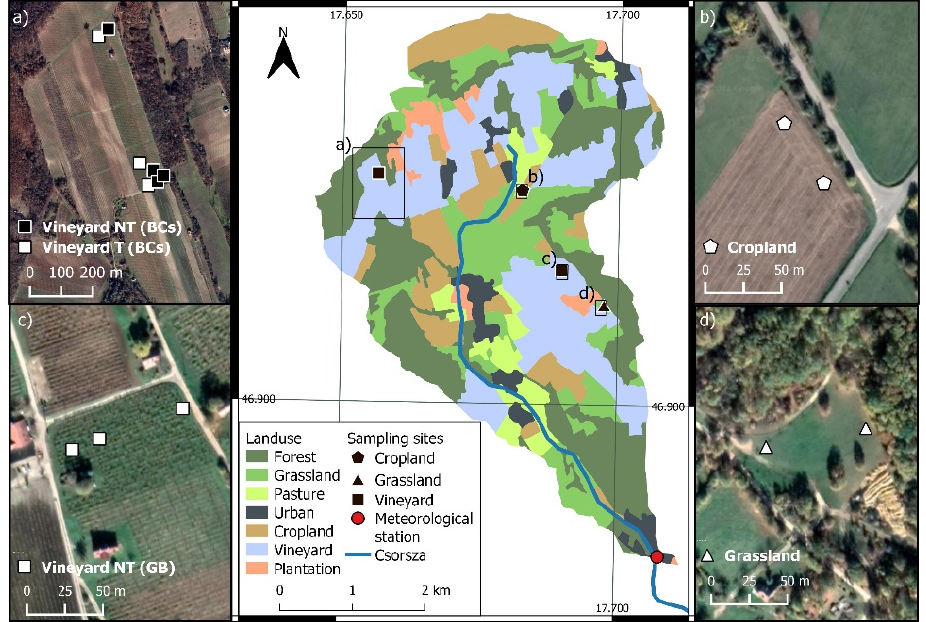
Figure 1. Area of the Csorsza study catchment showing locations of measurement points. Source of pictures: Google Earth. ( a ) vineyard (BCs), ( b ) cropland (maize), ( c ) vineyard (GB), and ( d ) grassland study sites.